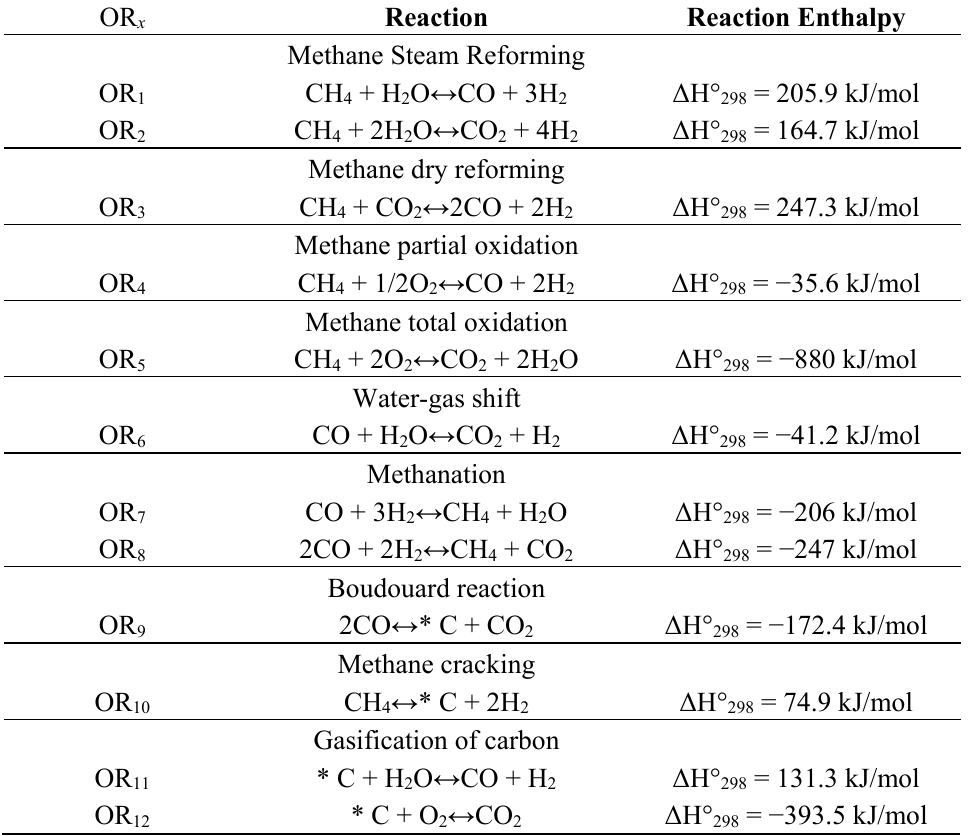
Table 2. Overall reactions (OR x ) in the methane reforming and oxidation